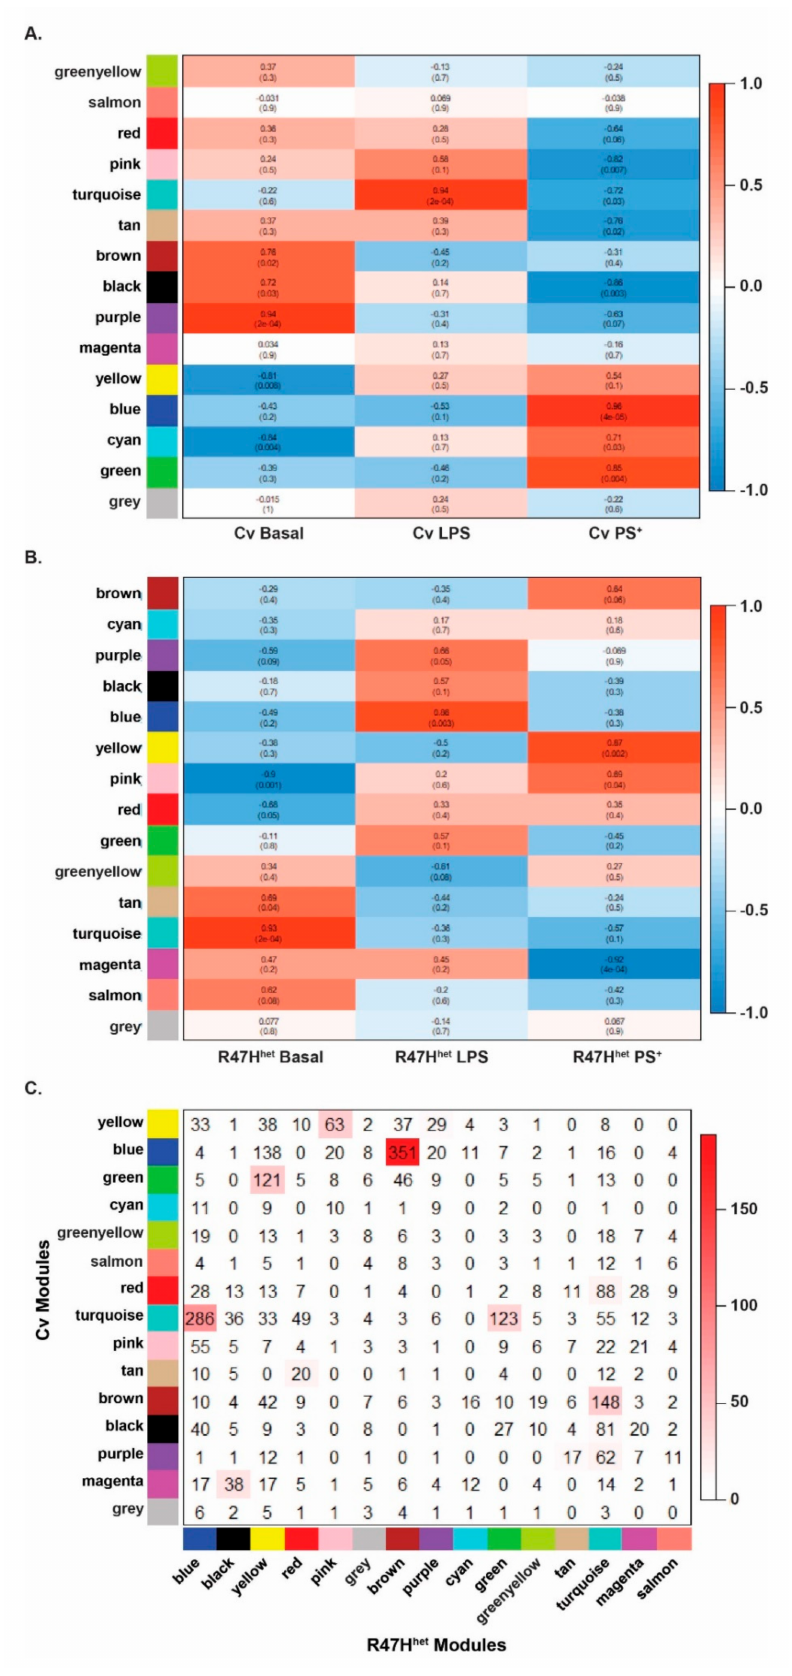
Figure 3. Network analysis. Based on the constructed networks, the relationship between the